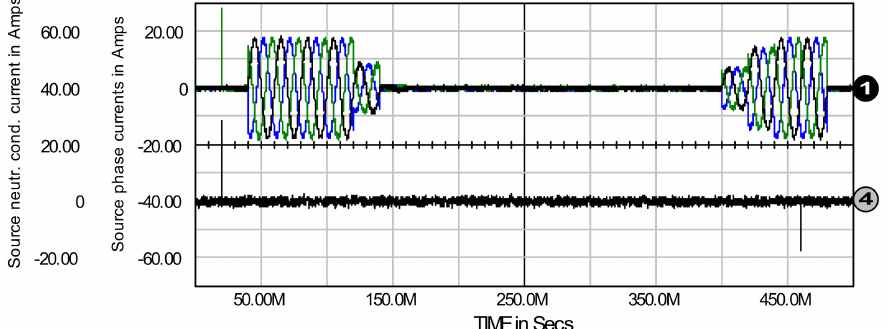
Figure 22. Source phase currents: waveforms 1–3, and load neutral conductor current: waveform 4.